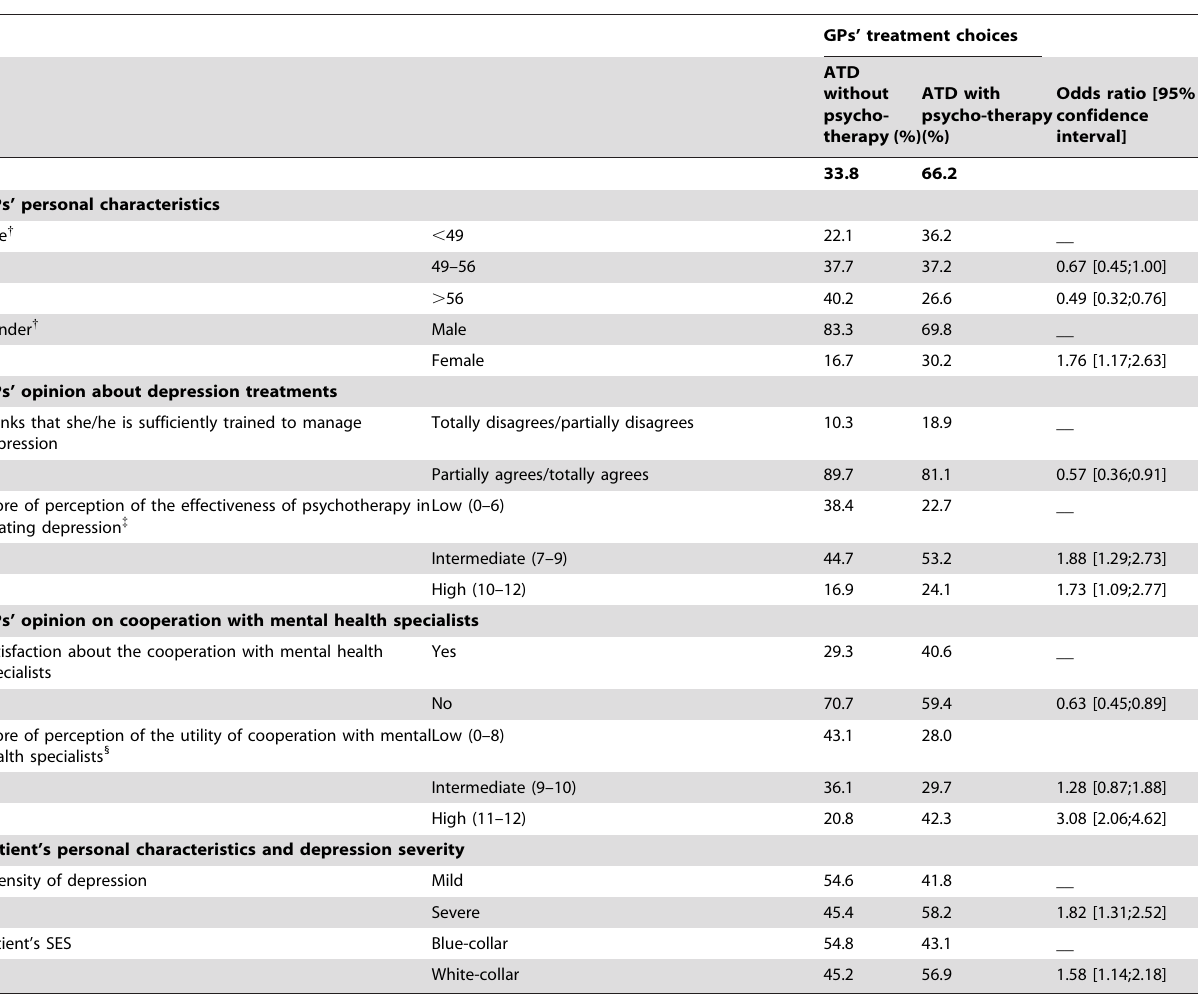
Table 4. Factors associated with the prescription of antidepressant treatment combined with psychotherapy versus an antidepressant alone (versus antidepressant therapy only, case-vignette, French nationwide panel of general practitioners, weighted multivariate logistic model,